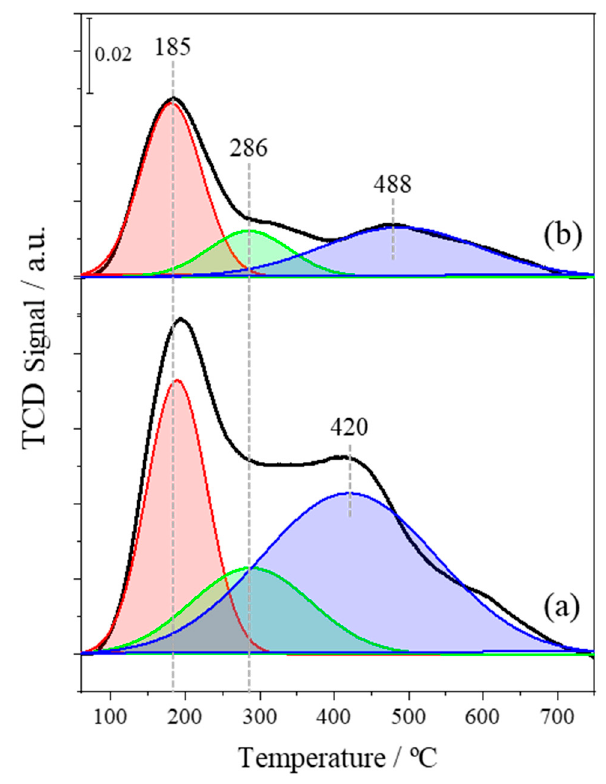
Figure 5. NH 3 -TPD profiles for the Cu-CHA zeolites ( a ) 2Cu-SAPO-34 and ( b ) 2Cu-SSZ-13. Table 3. XPS results for the Cu-CHA zeolite